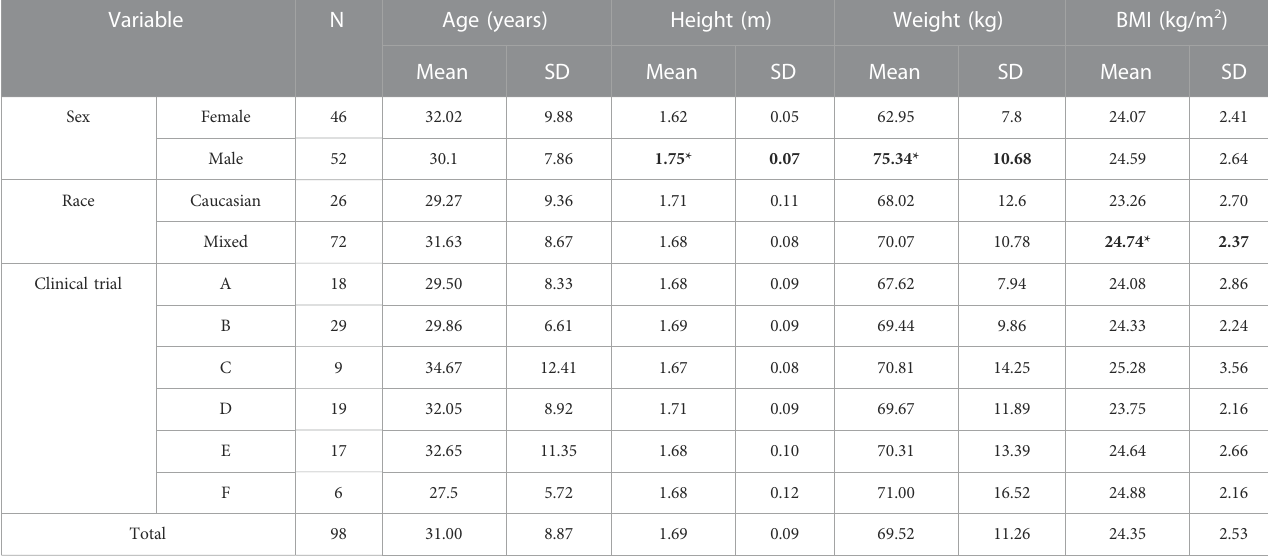
TABLE 2 Demographic characteristics of the study population according to sex, race, and clinical trial. Variable